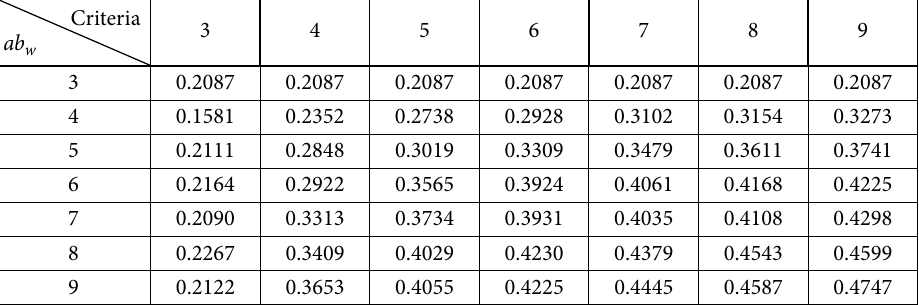
Table 4. The thresholds of consistency ratio (source: Liang et al., 2020) Criteria ab